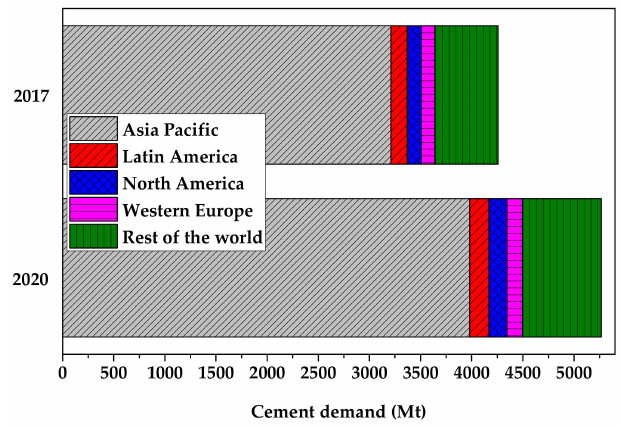
Figure 1. Annual cement production (data taken from [4,5]; [5] is based on IEA data from IEA (2020) Global cement production, 2010–2019, www.iea.org/data-and-statistics, accessed on 2 November 2021. All rights reserved; as modified by J. Kim, IAE).